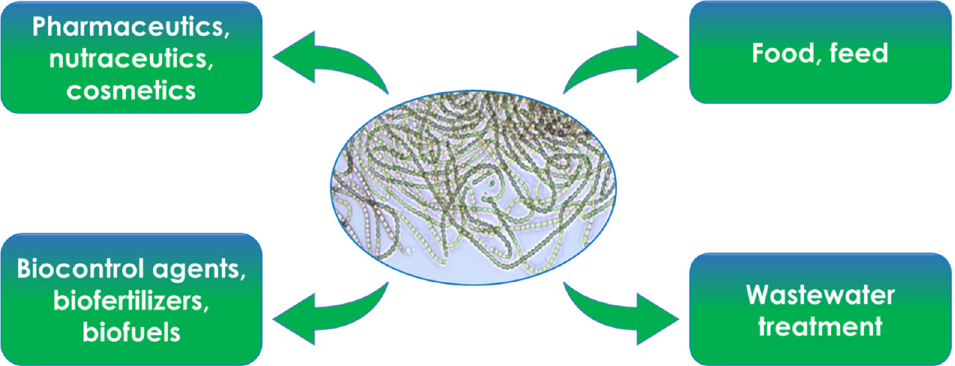
Figure 4. Overview of cyanobacteria general uses. Micrograph courtesy of Banco Español de Algas (BEA).